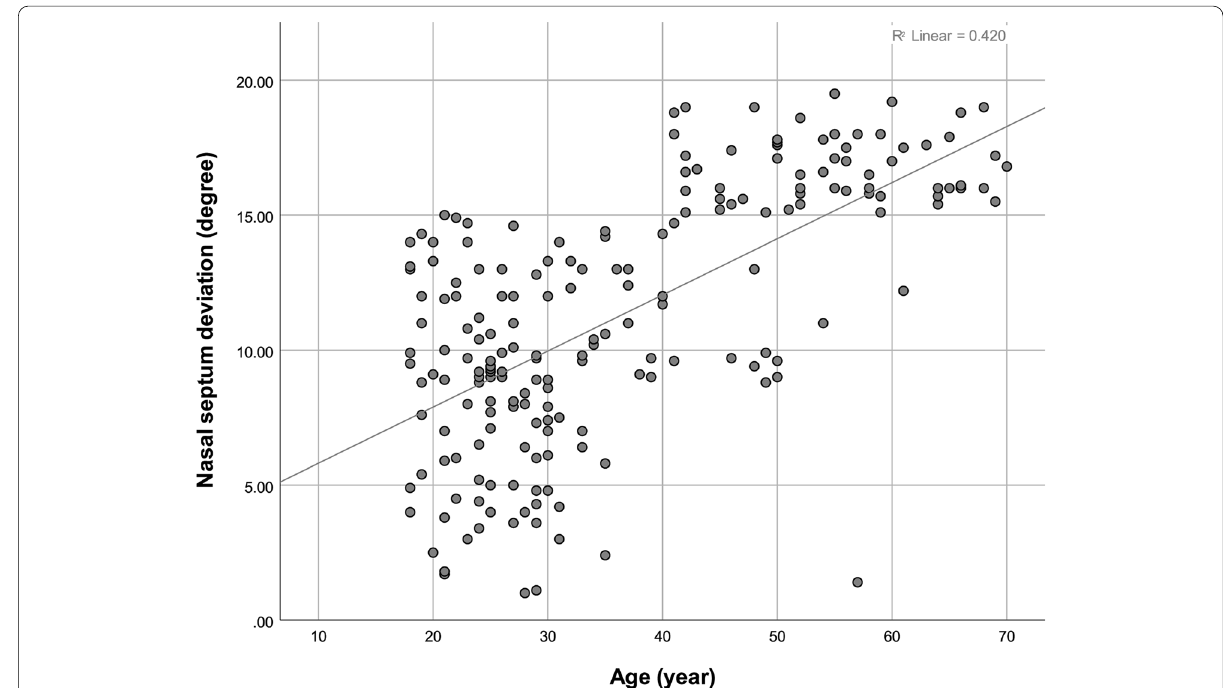
Fig. 5 A scatterplot showing the correlation between age (year) and the NSD extent (°)